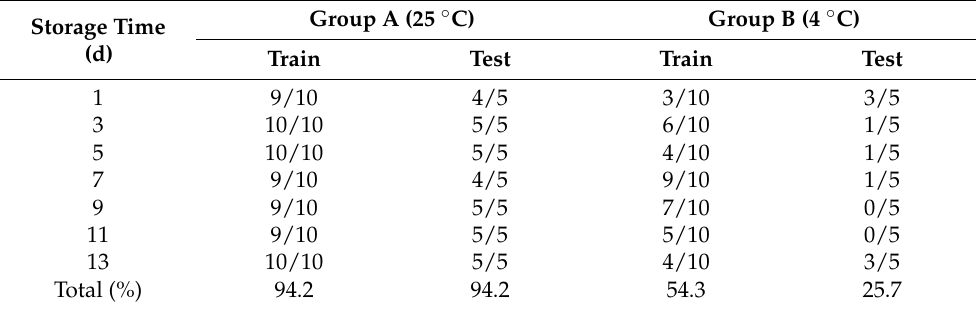
Table 4. Results of egg storage time discrimination in different storage conditions using the LDA